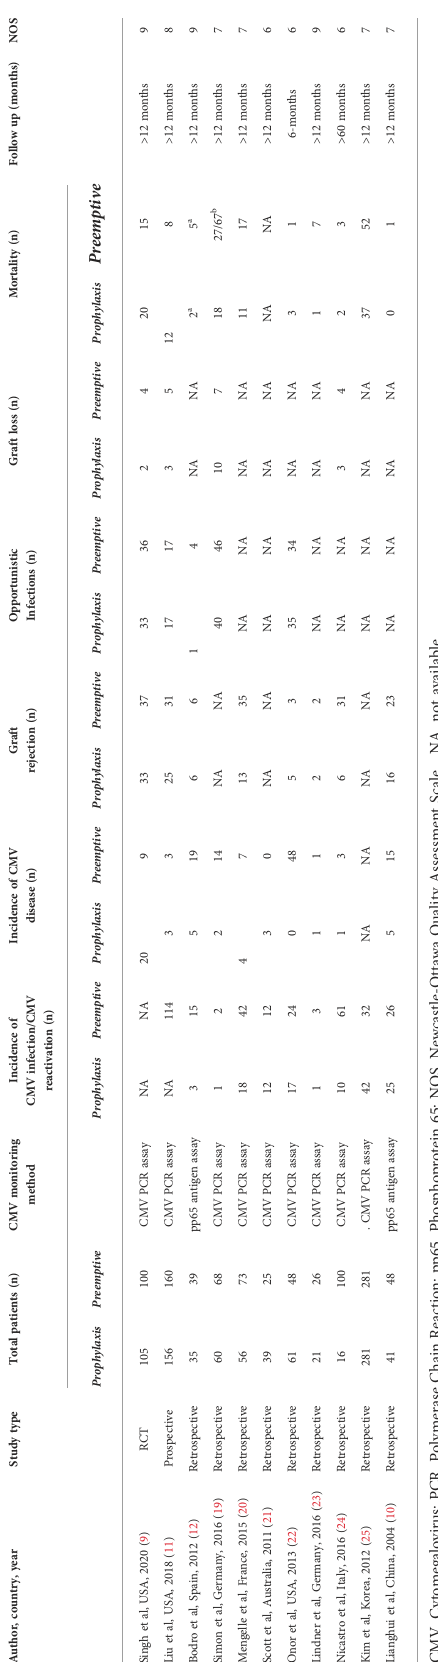
displayed high heterogeneity (I 2 = 89.7%; p = 0.002) (Figure 5).